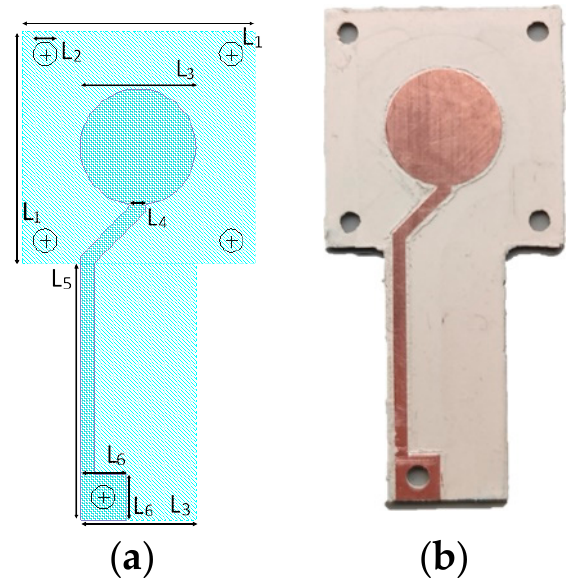
Figure 1. The layout ( a ) and a picture ( b ) of the electrode employed to perform measurements. The geometry was optimized to reduce parasitic effects. Table 2. Size of electrode parameters.